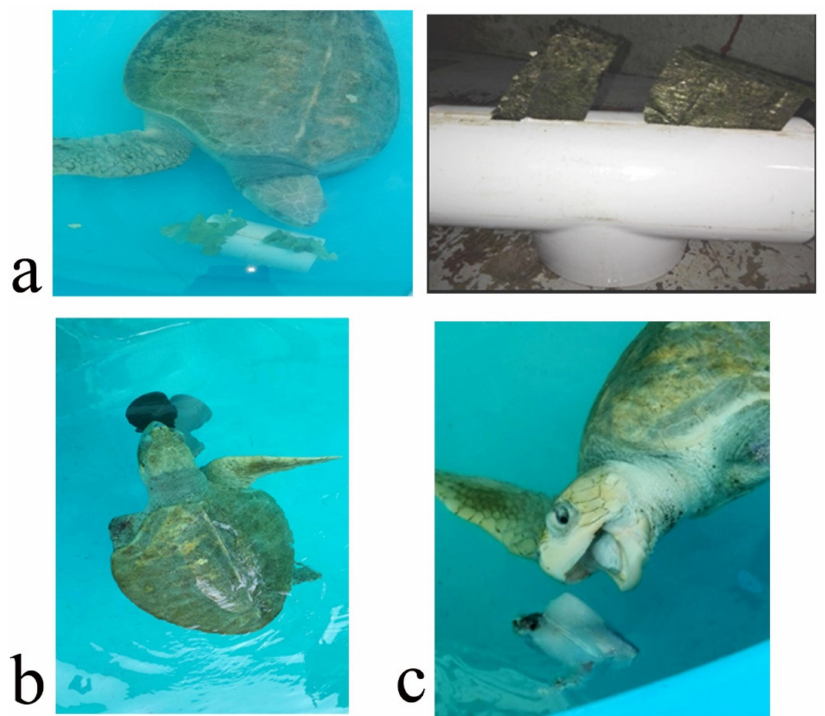
Figure 2. Environmental enrichment devices of the nutritional type used in the rehabilitation of an olive ridley turtle ( Lepidochelys olivacea ). ( a ) vegetable feeder to promote foraging; ( b ) feeder jar (nutritional, sensory); ( c ) ice block with food (nutritional,